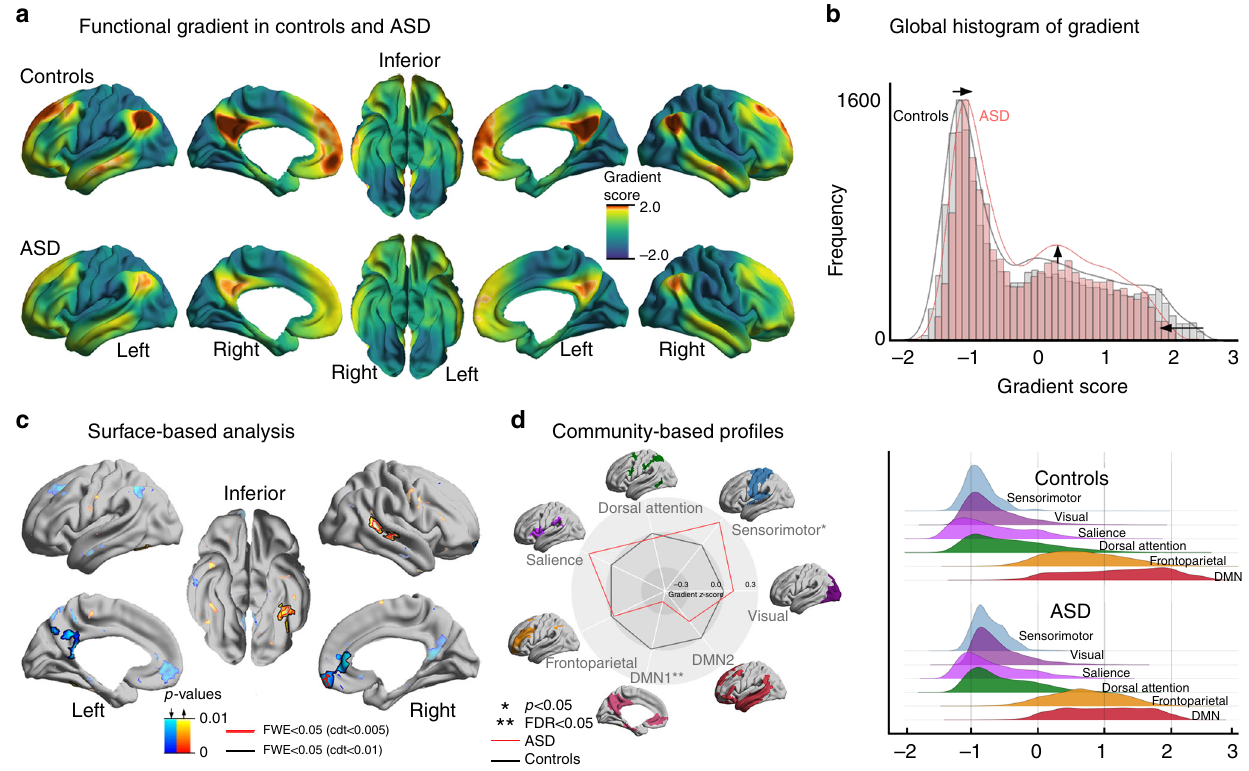
Fig. 1 Connectome gradient mapping in autism spectrum disorders (ASD) and neurotypical controls. a The principal gradient in controls describes a continuous coordinate system that runs from unimodal ( dark turquoise ) regions one end to transmodal regions on the other end ( sienna ), peaking in the default mode network (DMN). Regions with similar connectivity patterns show similar coloring. In ASD, while the gradient is overall similar, one readily appreciates lower values in the DMN core. b Global histogram analysis con fi rmed that extreme values were suppressed in ASD compared to controls, while those in the mid-range increased. c Surface-wide statistical comparisons between controls and ASD, with increases/decreases in ASD shown in red/ blue. Findings were obtained using surface-based linear models implemented in SurfStat. d Community-based z -score analysis of gradient score (with respect to controls) shows signi fi cant reductions primarily in DMN both spider (left) and joy (right)